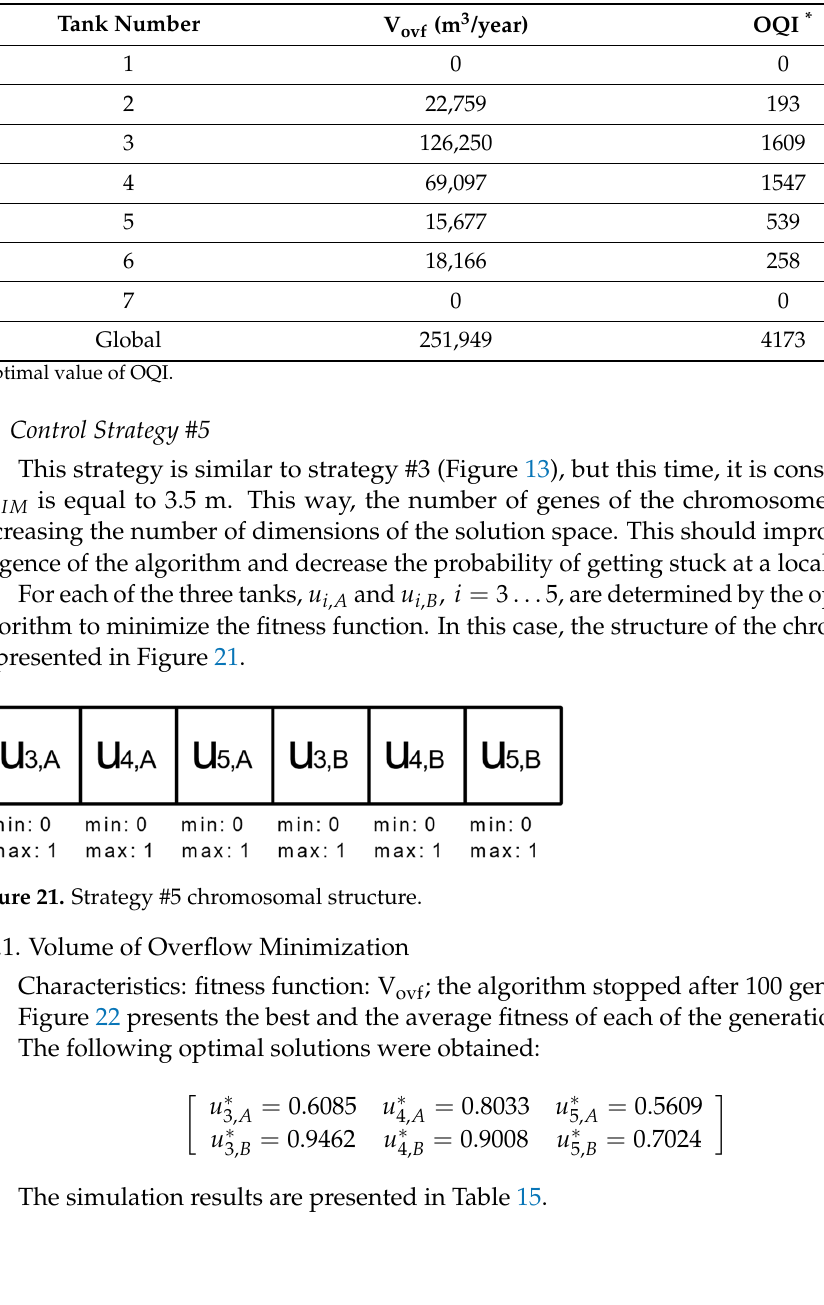
Figure 22. Best and average fitness evolution in control strategy #5 when minimizing V (cid:2925)(cid:2932)(cid:2916) . The following optimal solutions were obtained: (cid:3428)𝑢 (cid:2871) , (cid:3002)∗ (cid:3404) 0.6085 𝑢 (cid:2872) , (cid:3002)∗ (cid:3404) 0.8033 𝑢 (cid:2873) , (cid:3002)∗ (cid:3404) 0.5609 𝑢 (cid:2871) , (cid:3003)∗ (cid:3404) 0.9462 𝑢 (cid:2872) , (cid:3003)∗ (cid:3404) 0.9008 𝑢 (cid:2873) , (cid:3003)∗ (cid:3404) 0.7024 (cid:3432)